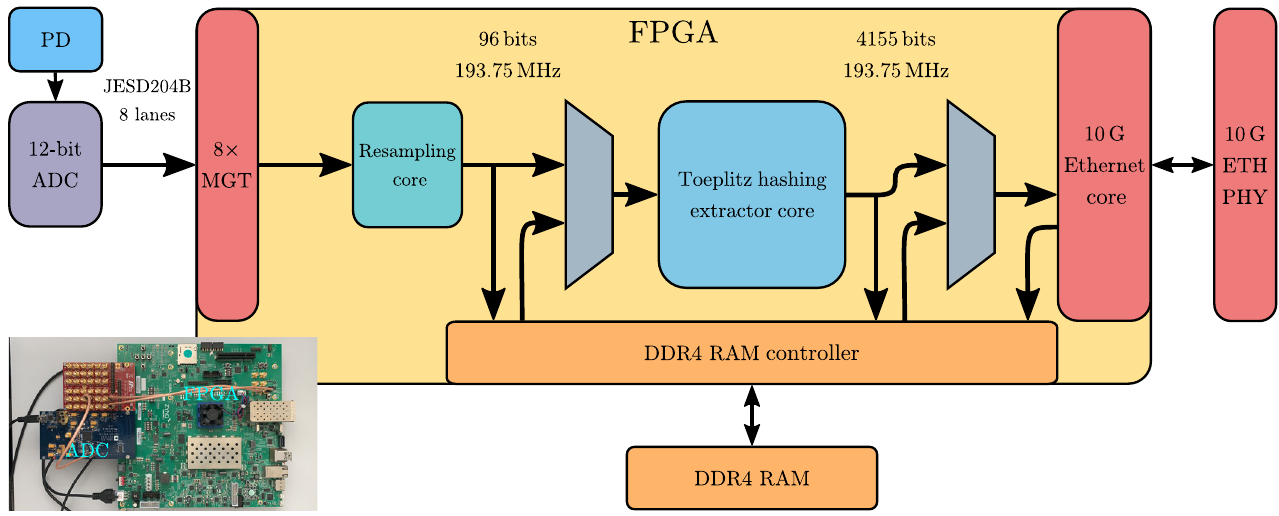
FIG. 7. Schematic of the real-time postprocessing board used to generate certified random numbers. The analog signal generated by the optical setup described in Fig. 2 is digitized by an ADC and then further processed by an FPGA board. Additionally, the number of bits during each step of the process, along with the inverse duration of each time step, is shown above the various modules in the schematic. PD, photodiode; ADC, analog-to-digital converter; MGT, multigigabit transceiver; DDR4 RAM, double data rate 4th generation random access memory; ETH PHY, Ethernet physical layer. Inset: photograph of the actual postprocessing board comprising the ADC and the